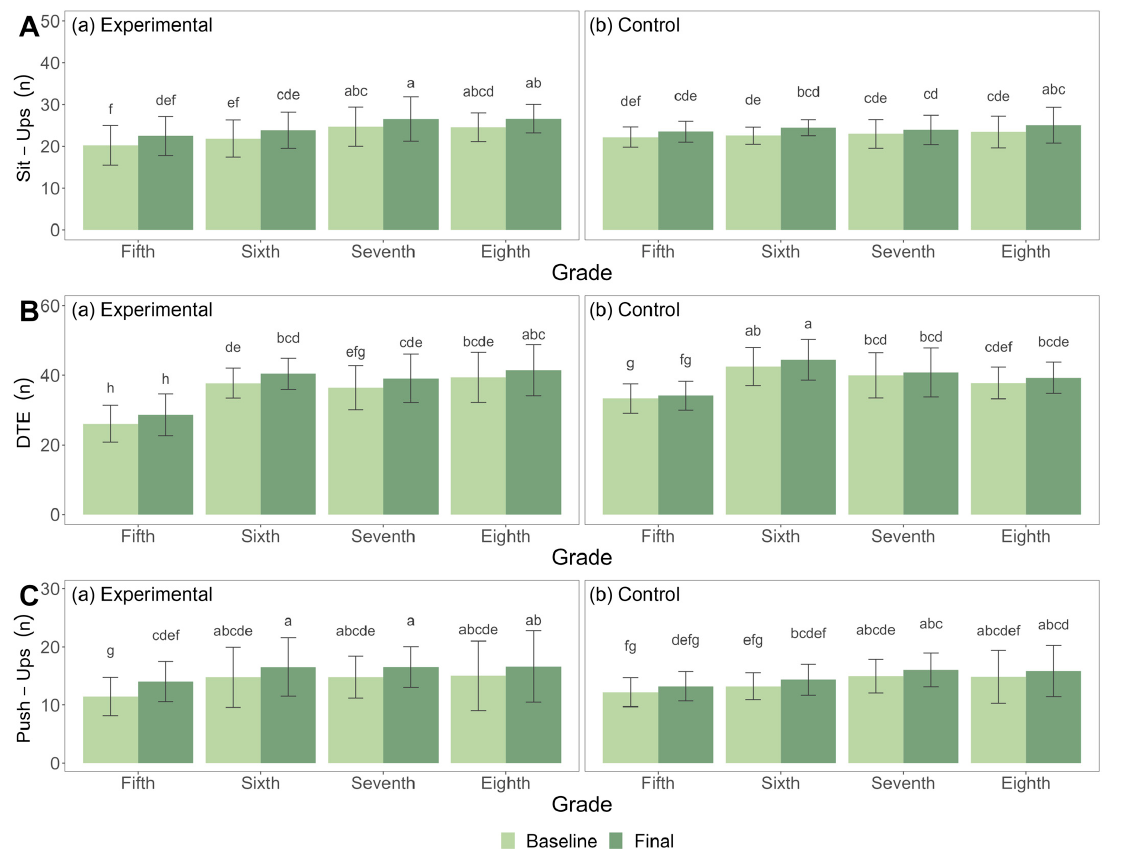
Figure 2. Mixed model (2 × 2 × 4) three-way ANOVA showing the effect of the group (experimental and control; panels (a) and (b)), time point (baseline and final), and grade (fifth, sixth, seventh, eighth) on sit-up, DTE, and push-up performance. ( A – C ) represent the main and interaction effects for sit-ups, DTE, and push-ups, respectively. We used alphabetic characters to convert a vector of p -values into a letter summary to indicate significantly different means. Based on a post-hoc Tukey’s HSD test, the letters above the bars indicate significant the differences between the groups, time points, or grades ( p < 0.05). The means with at least one common letter are not significantly different. For example, the means for the fifth grade in the experimental group (baseline vs. final) may seem significantly different based on the contrasting letter labels (f vs. def). The means are different, however not significantly, because they share a common letter f. The bar plots display the group mean and error bars as standard deviation.